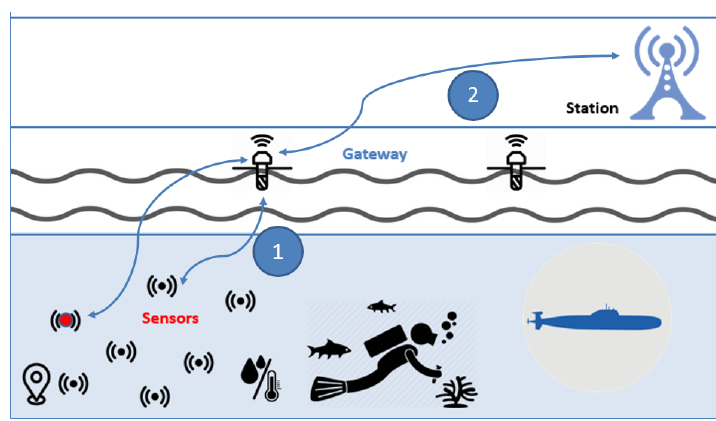
Figure 25. Blind Approach with Underwater